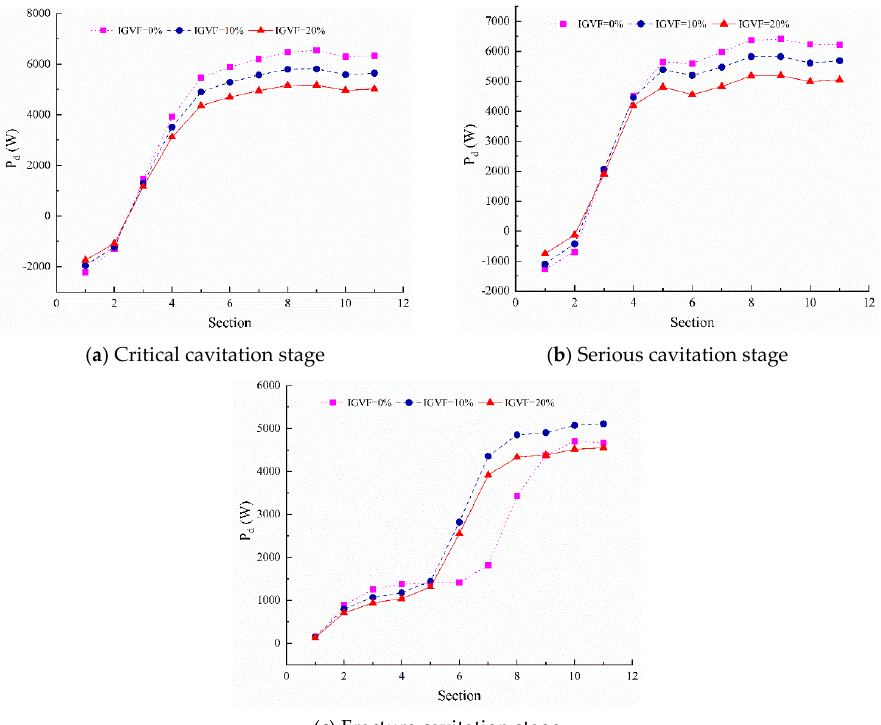
Figure 15. The variation curve of the dynamic pressure power through each section under different IGVFs at each cavita- tion stage. IGVFs at each cavitation